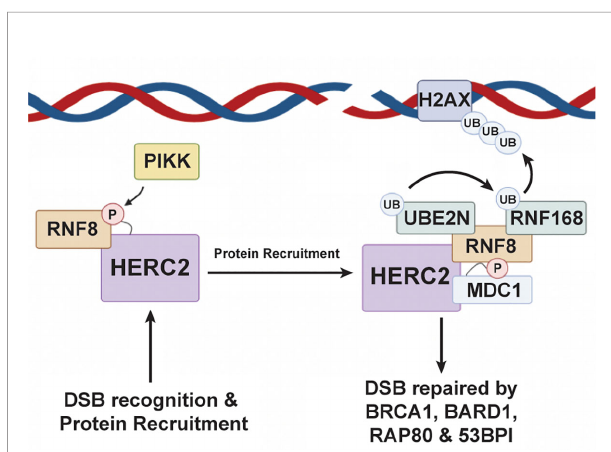
FIGURE 4 | HERC2 serves as a scaffold to facilitate H2A ubiquitylation in response to DNA double strand breaks. HERC2 initiates the repair response for DSBs by using its catalytic HECT domain as a binding scaffold for RING fi nger protein 8 (RNF8), a RING E3 ubiquitin ligase, to bring RNF8 into close proximity to a site of DNA damage. After binding RNF8 to its HECT domain, HERC2 coordinates the formation of a complex between UBE2N (aka Ubc13), an E2 ubiquitin conjugating enzyme, and RNF168 to catalyze the attachment of K63-polyubiquitin chains onto histones at the site of damaged DNA. This HERC2-mediated K63-polyubiquitylation activity then signals for the recruitment of healing factors like breast cancer gene 1 (BRCA1), receptor associate protein 80 (RAP80), and 53BP1 to elicit an effective DDR response. This fi gure was created with